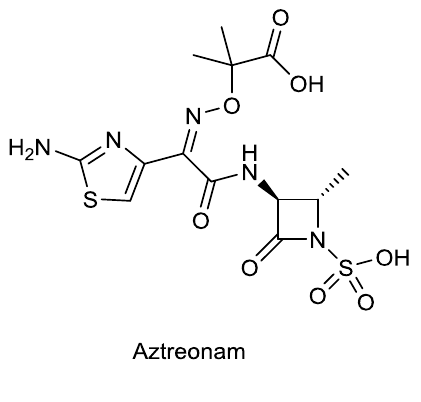
Figure 8. Chemical structure of